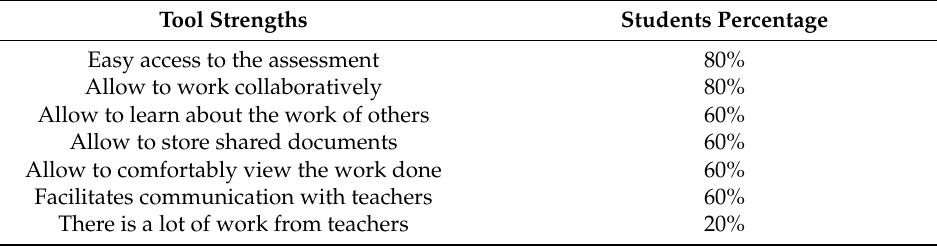
Table 6. Students’ assessment about work environment using Microsoft